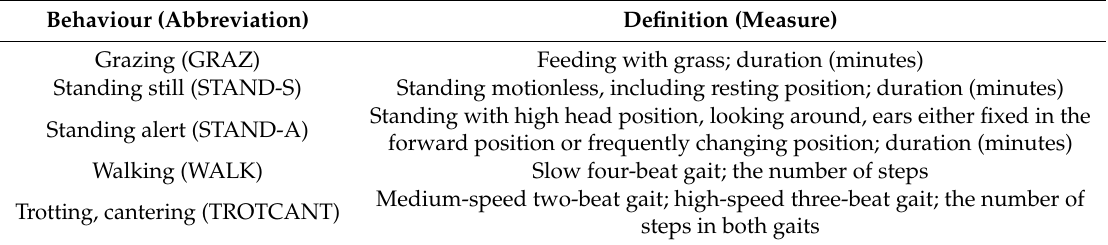
Table 1. Behaviours observed during 5-min pre-playback, playback and post-playback phases of the trial.